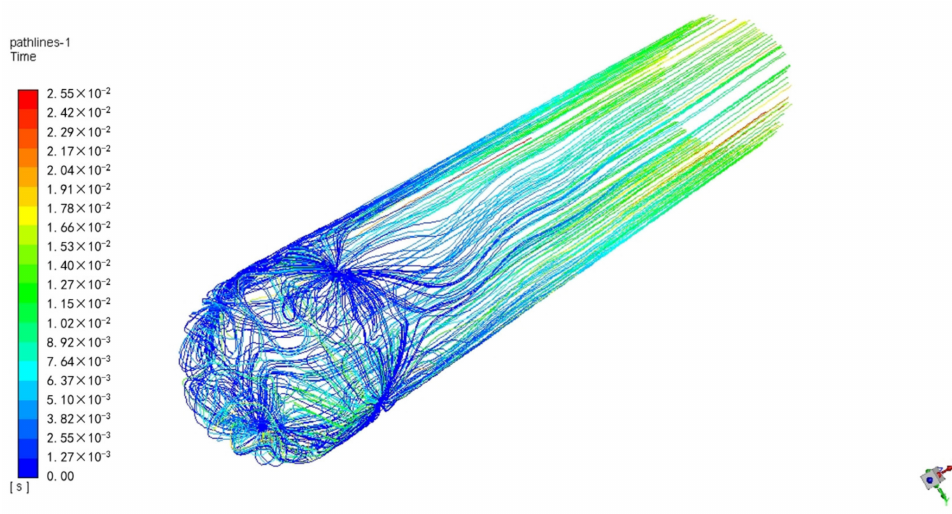
Figure 16. Trajectory map of rotary jet in the wellbore.